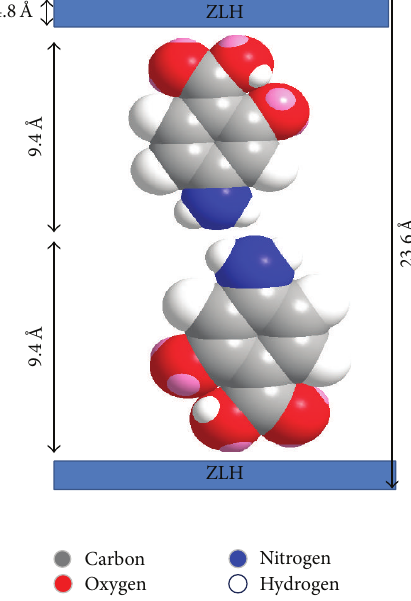
Figure 2: Spatial orientation of PAS in interlayers of ZLH (nanocomposite-A).